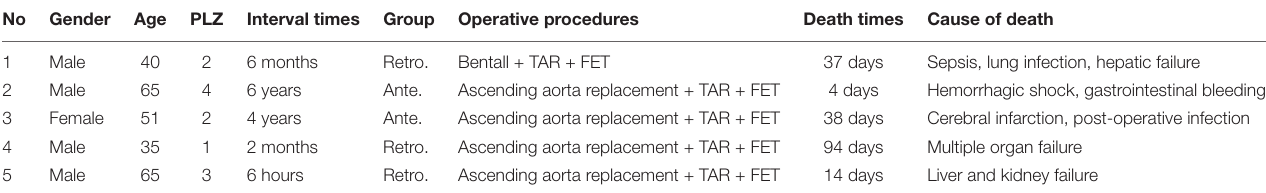
TABLE 5 | Details of deaths during the follow-up